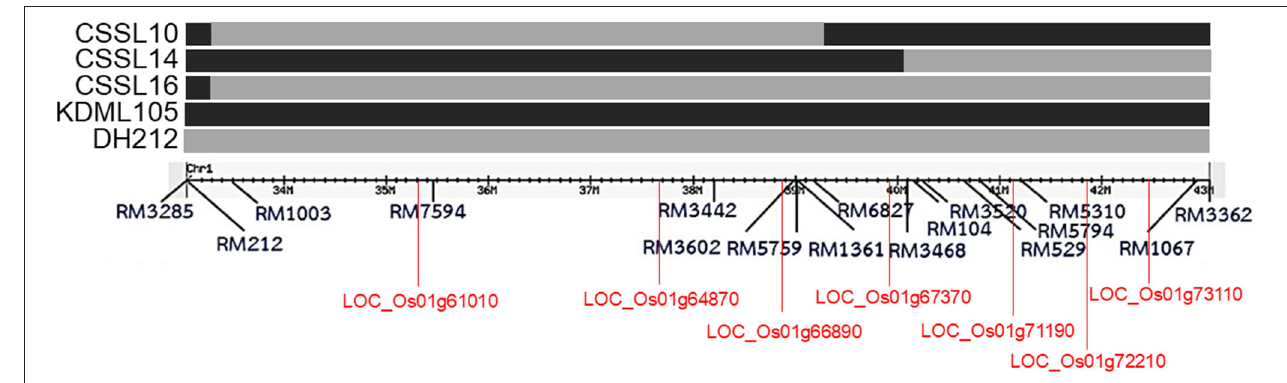
FIGURE 1 | The chromosomal segment substitution line of CSSL10, CSSL14, and CSSL16 with regions between RM1003 and RM3362 markers on chromosome 1. Some genes with putative functions, Nodulin ( LOC_Os01g61010 ), BTBZ1 ( LOC_Os01g66890 ), PSB28 ( LOC_Os01g71190 ), and ERD ( LOC_Os01g72210 ), are